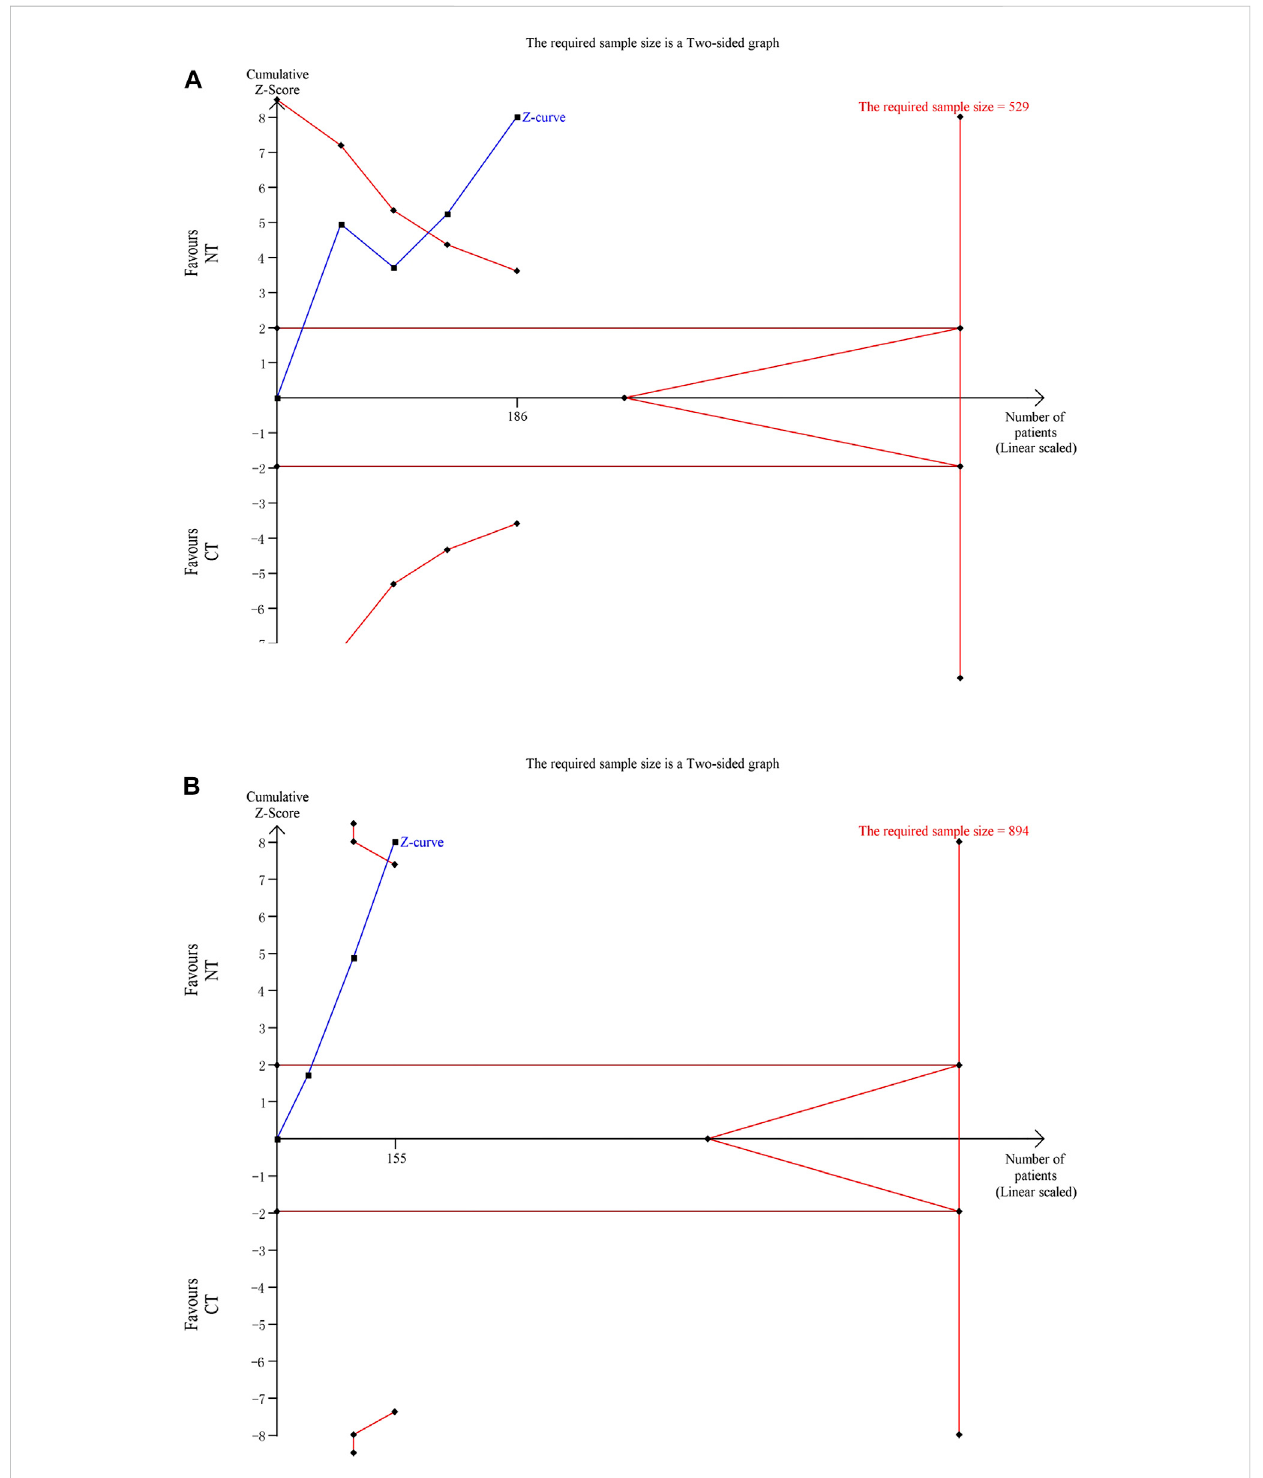
FIGURE 4 Trial sequential analyses for primary outcomes: (A) time to the fi rst defecation and (B) time to the relief of abdominal symptoms.